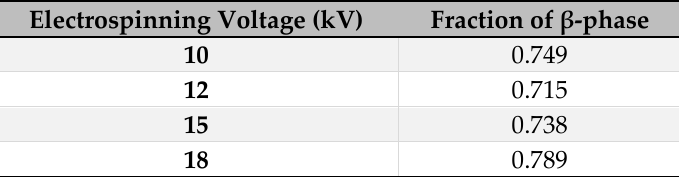
Figure 2. FTIR spectrum of the nanofibers electrospun at four different voltages. Table 3. Fraction of β -phase at different electrospinning